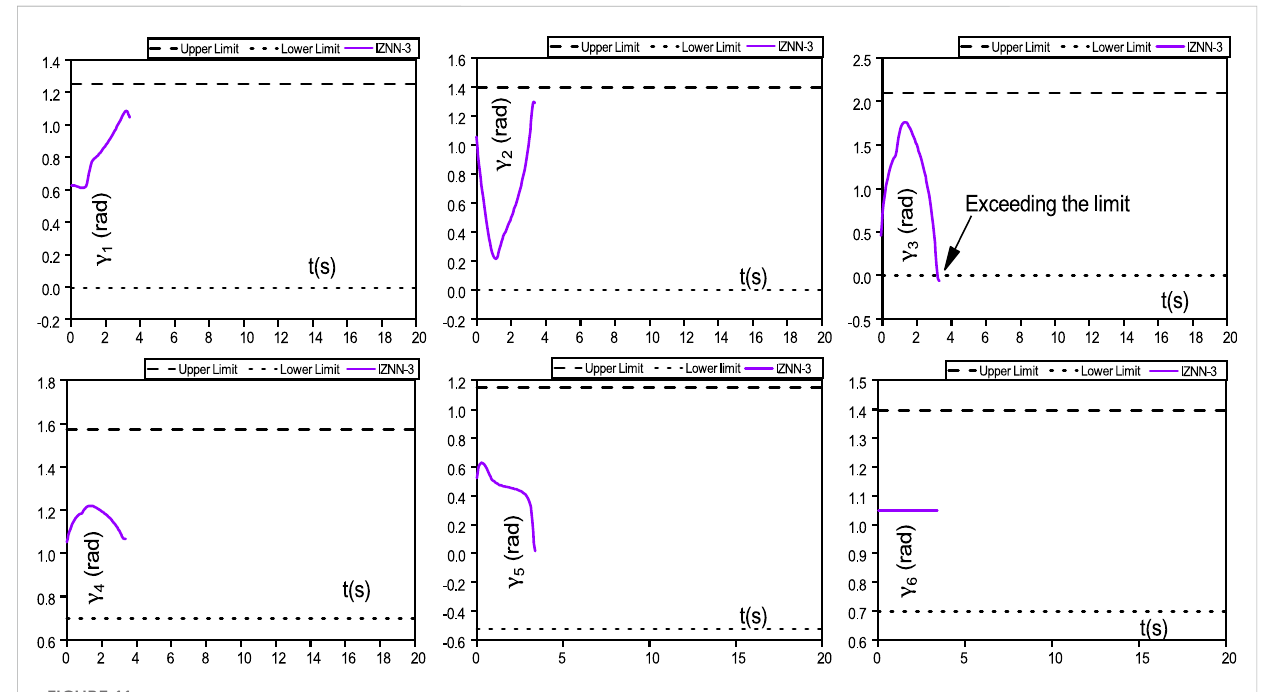
FIGURE 11 The IZNN-3 model-controlled wheeled robot fails trajectory tracking with joint angles exceed limits.